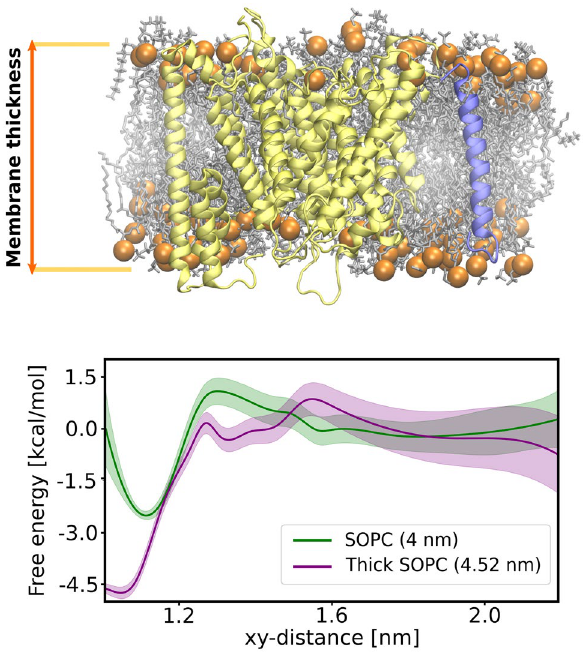
Figure 6. (Top) Structural representation of the membrane thickness definition. (Bottom) The free energy profiles for the substrate binding to γ -secretase in the SOPC membrane (green) and in the SOPC membrane with the imposed thickness of DPPC/Chl membrane